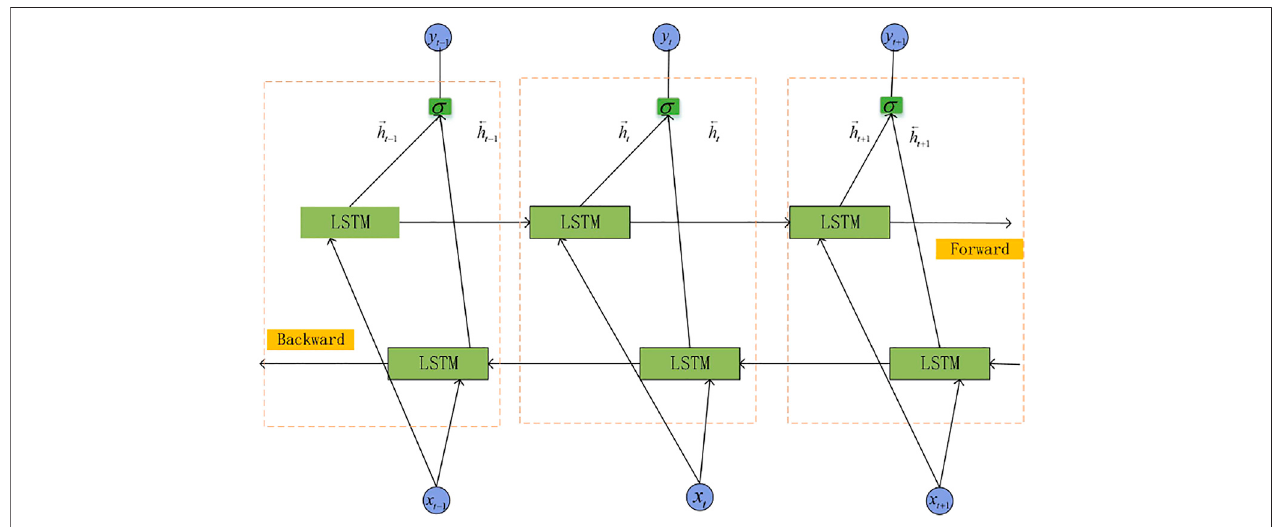
FIGURE 2 | BILSTM model